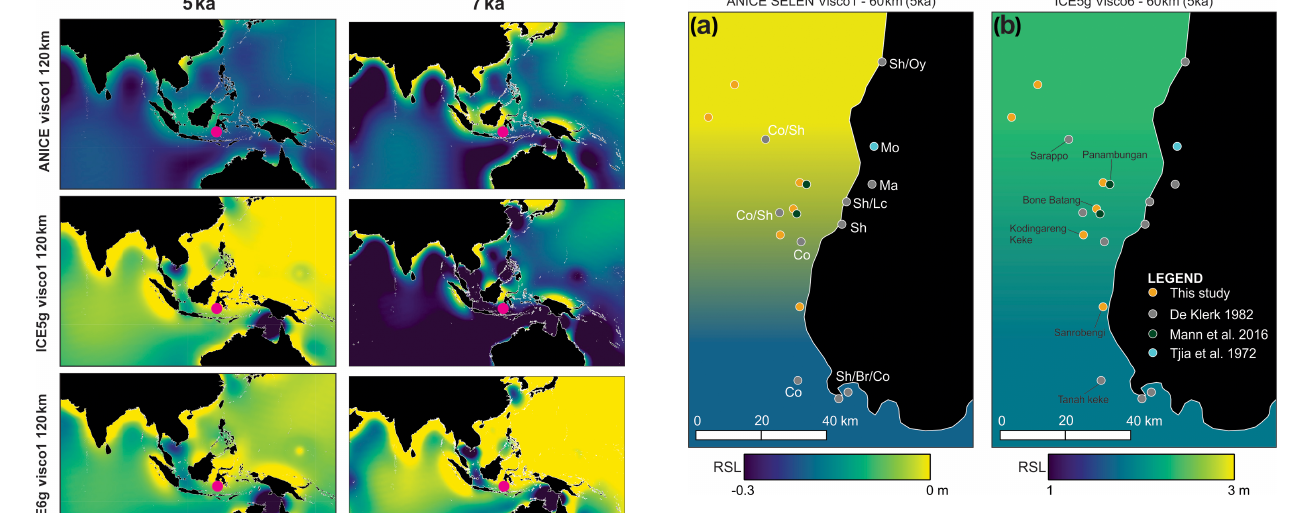
Figure 7. Location of the RSL data presented in this study, Mann et al. (2016), De Klerk (1982), and Tjia et al. (1972) compared with RSL as predicted by GIA models. Land areas are filled in black. Here we show the models predicting the lowest (a) and highest (b) RSL in the Spermonde Archipelago. Labels in (a) represent the type of indicator reported by De Klerk (1982) and Tjia et al. (1972). Island names in (b) refer to the islands mentioned in the